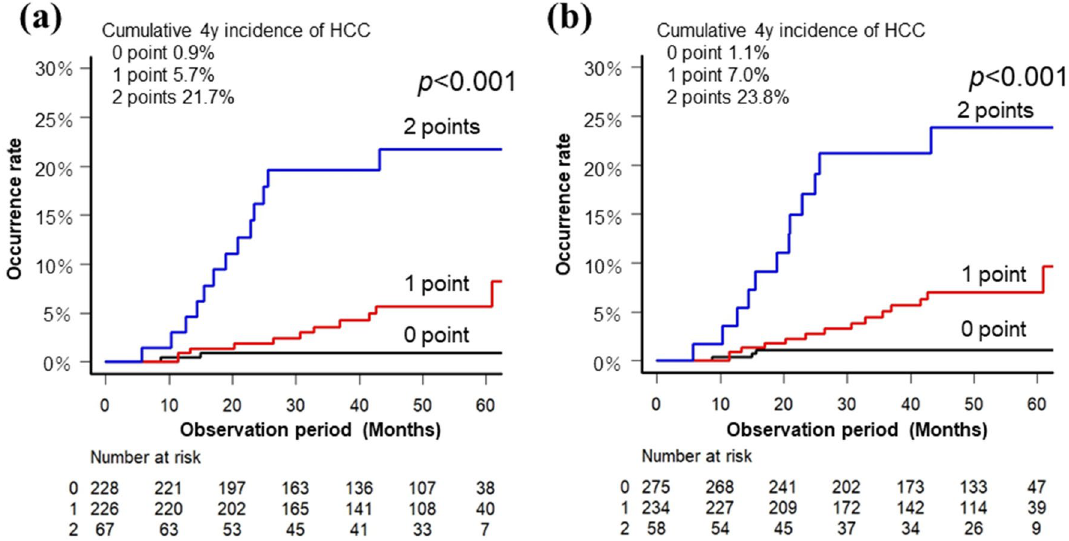
Figure 4. Identification of high-risk and low-risk groups of HCC due to age and LSM. Cumulative incidence of HCC according to age and LSM divided into three groups. When the age and LSM were above the cut-off values, 1 point was assigned to each and divided into three groups of 0–2 points. The black line indicates 0-point cases, red line indicates 1-point cases, and blue line indicates 2-point cases. ( a ) When grouped according to age and LSM pre-treatment, the age was 71 years, and the cut-off value for LSM was 9.2 kPa. ( b ) When grouped according to age and LSM at the time of SVR24, the age was 71 years, and the cut-off value for LSM was 8.4 kPa. HCC, hepatocellular carcinoma; LSM, liver stiffness measurement; SVR24, sustained virological response at 24